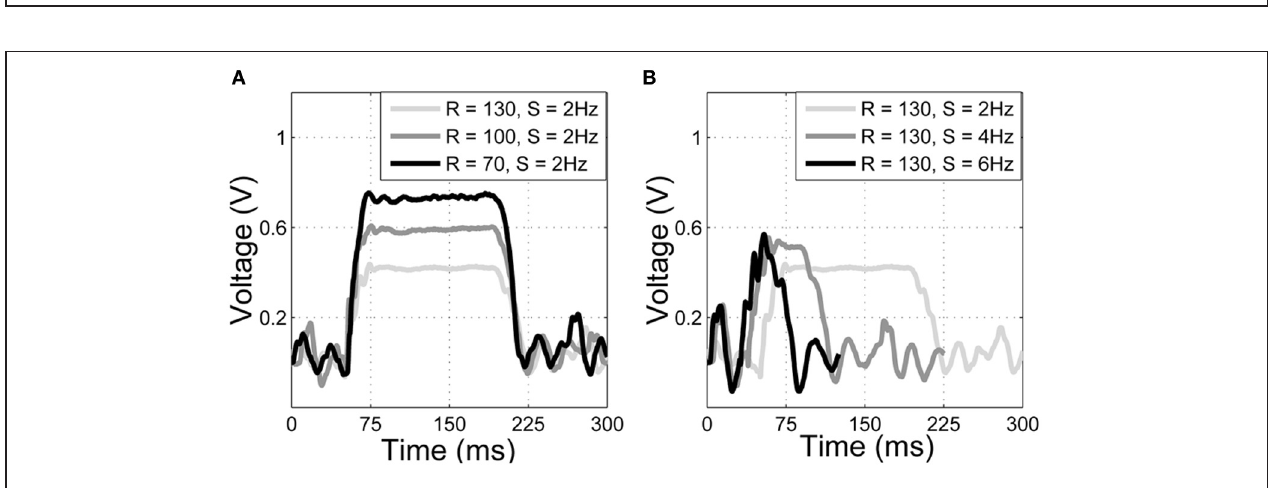
deflection height varies predictably with radial distance. (B) three deflections at the same radial distance but at different speeds. Contact duration varies predictably with speed. Contact latencies are for clarity of